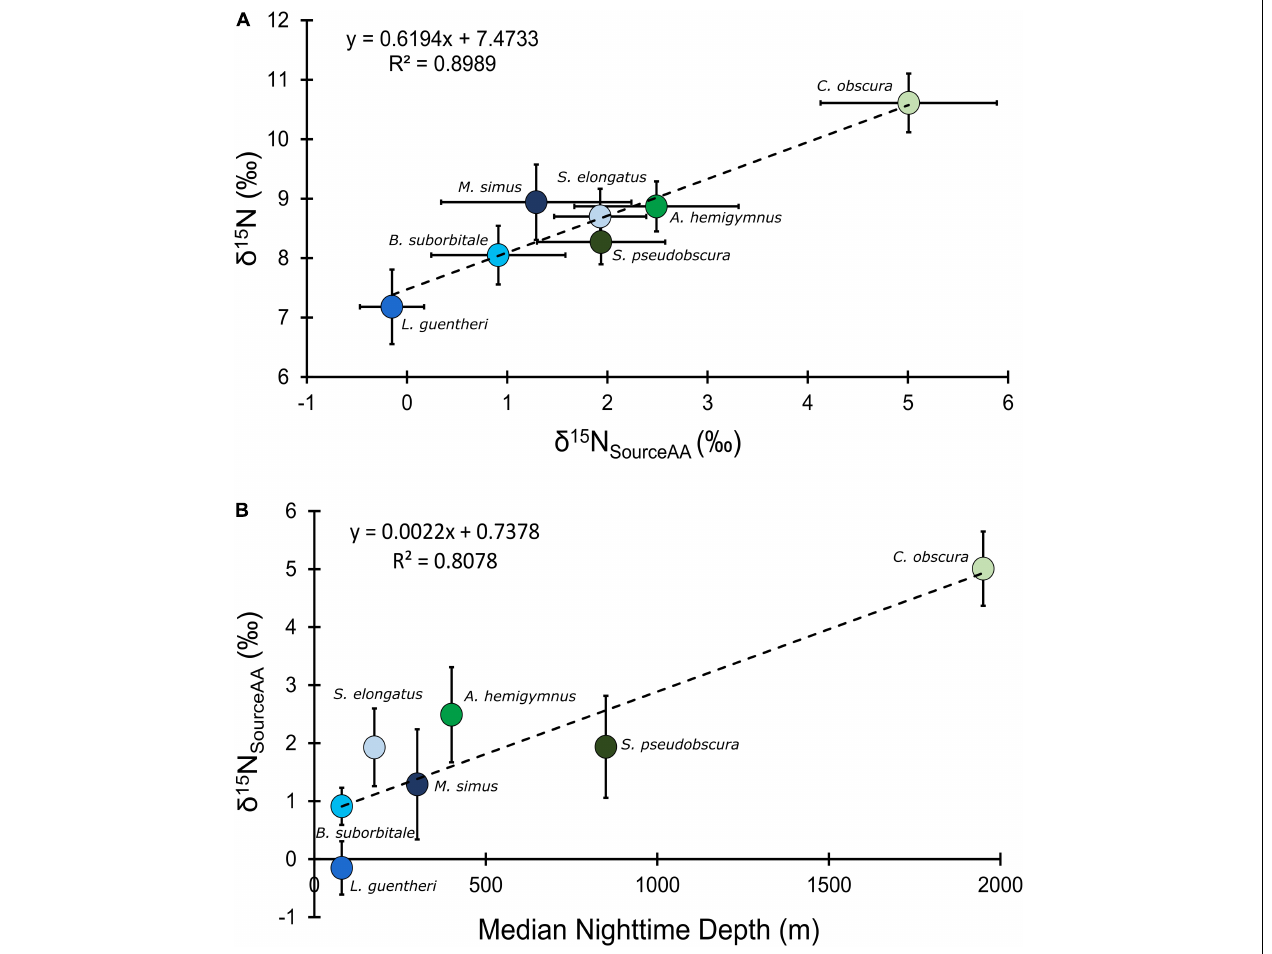
FIGURE 6 | (A) Bulk tissue δ 15 N values of deep-pelagic fishes as a function of δ 15 N sourceAA values. (B) δ 15 N sourceAA values as a function of median nighttime depth of occurrence. δ 15 N sourceAA represents the averaged value for each fish species. Blue circles represent vertical migrators, green circles represent non-migrators, and error bars represent the standard error for each species.